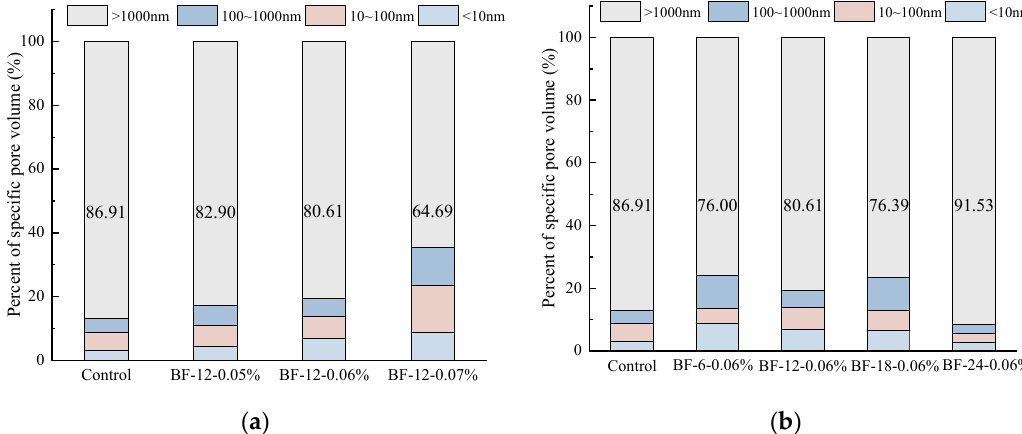
Figure 6. Percent of specific pore volume of BFRCs with different ( a ) BF content; ( b ) BF length.